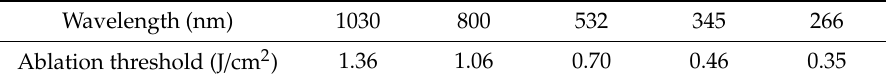
Table 1. Calculated values of the aluminum ablation threshold, for di ff erent